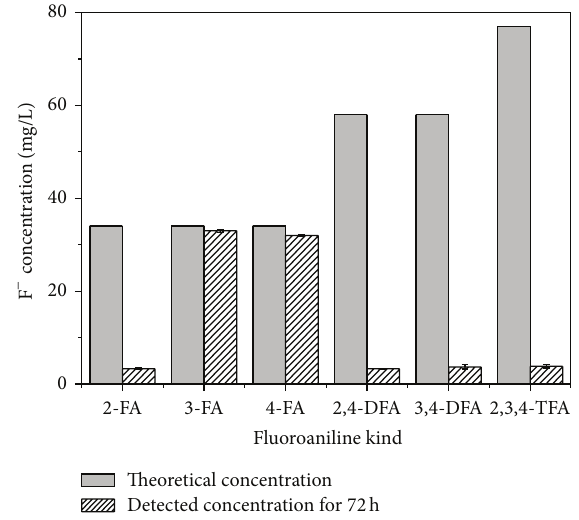
Figure 2: Fluorine ion produced from fluoroanilines as the sole carbon and nitrogen source for